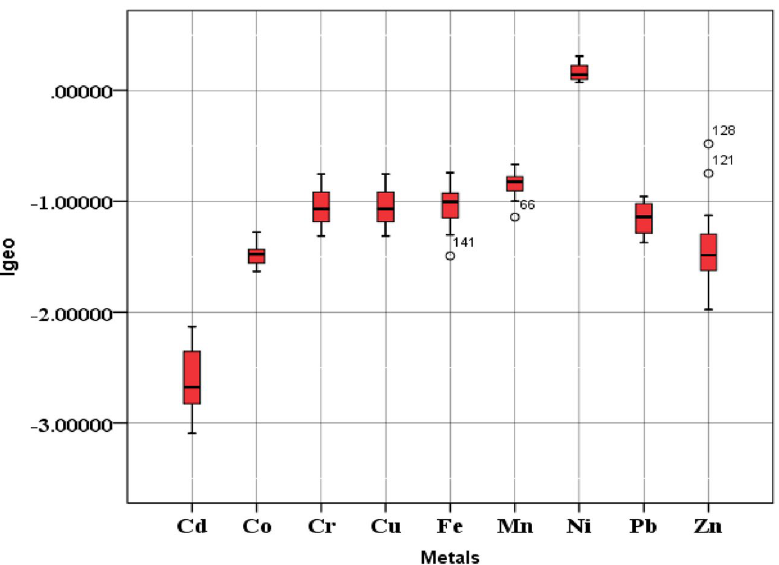
Figure 5. Box plots of Igeo values for TEs in the soils of farms.